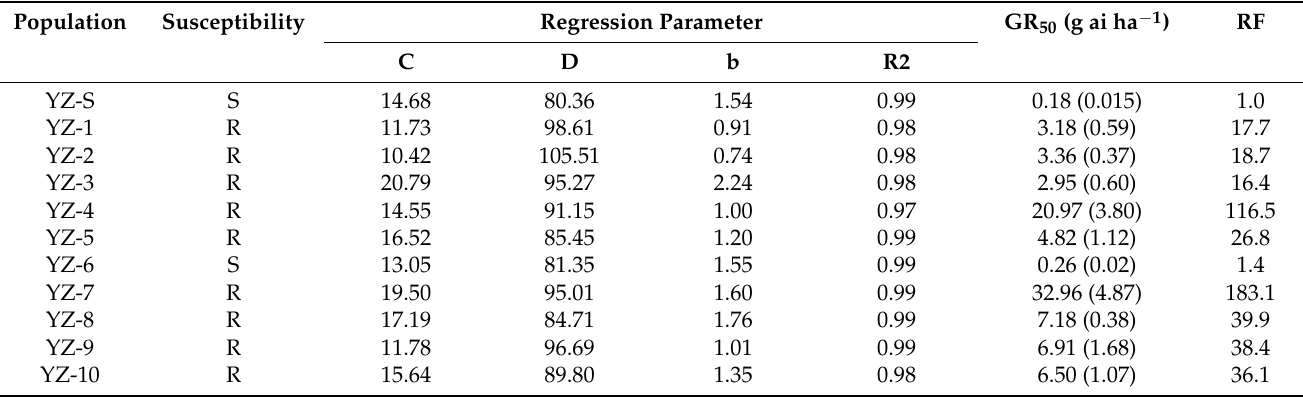
Table 1. Parameter values of log-logistic equation for whole-plant response assays of 11 A. auriculata populations to